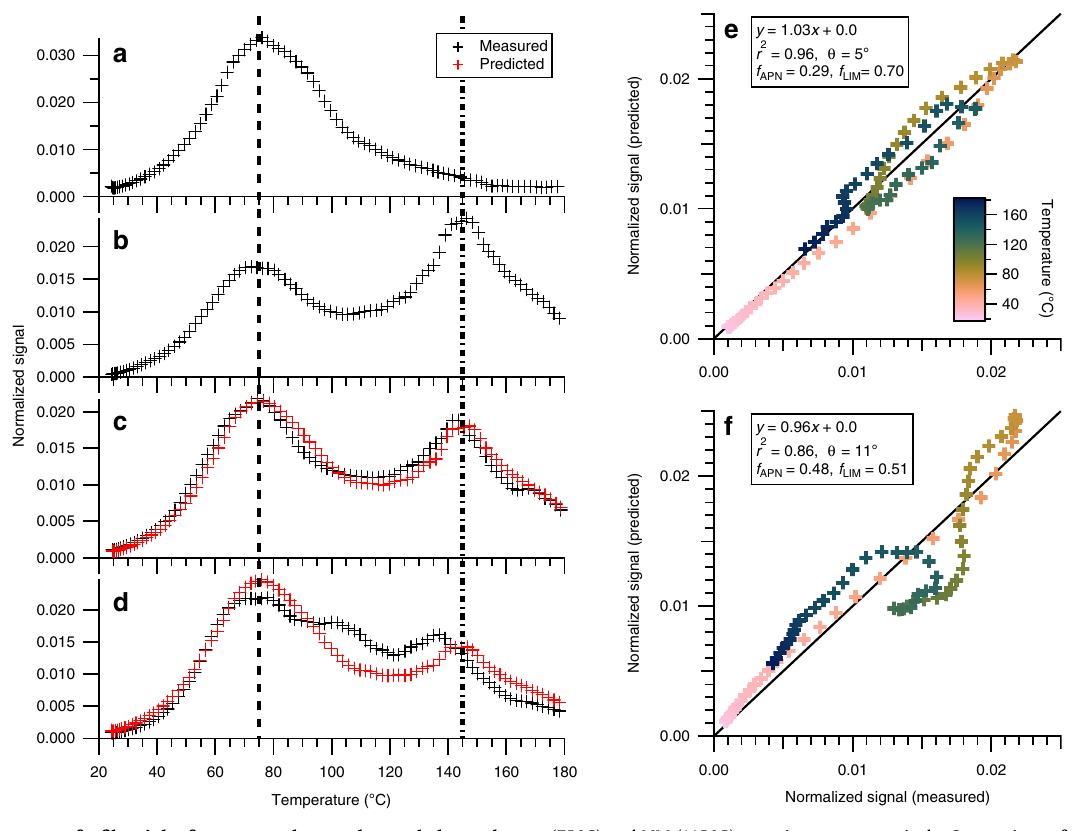
(75°C) and LIM (145°C) experiments, respectively. Comparison of measured thermogramsin e SEQand f MIXexperimentswiththosepredictedbasedonlinear combinationsofAPNandLIMexperiments.Solidlinerepresents1:1.Datapointsare coloredbytemperature. θ isaspectralcontrastangle,and f APN and f LIM indicatethe signal fractions of APN and LIM experiments contributing to secondary organic aerosol estimated via multiple linear regression analysis,